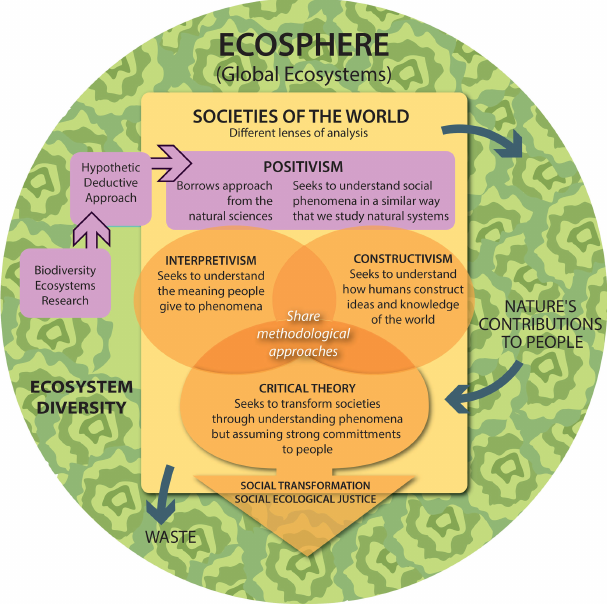
Fig. 1 . The analysis of social-ecological systems. On the left side of the figure we find the research approaches used to study biodiversity and ecosystems. Inside the yellow box are the social science traditions discussed in this paper. Surrounding it, we illustrate that people benefit from nature (or ecosystem services) and that human societies discharge waste into